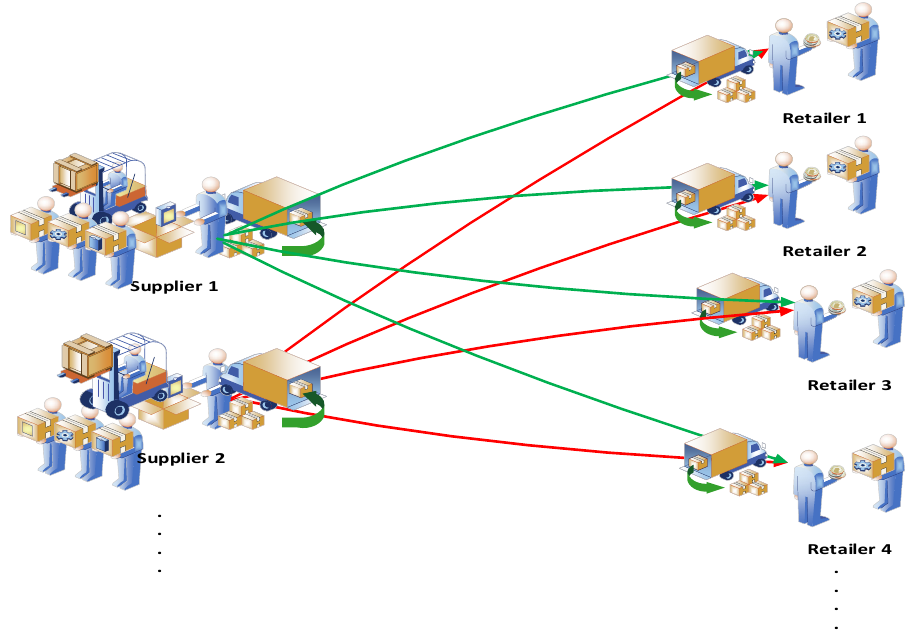
Figure 1. A framework of B2B e-commerce logistics model.